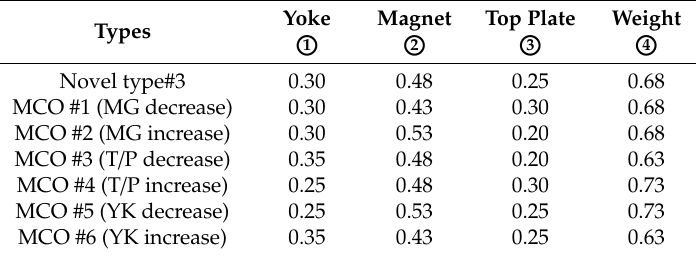
Table 9. Magnetic circuit design parameters.